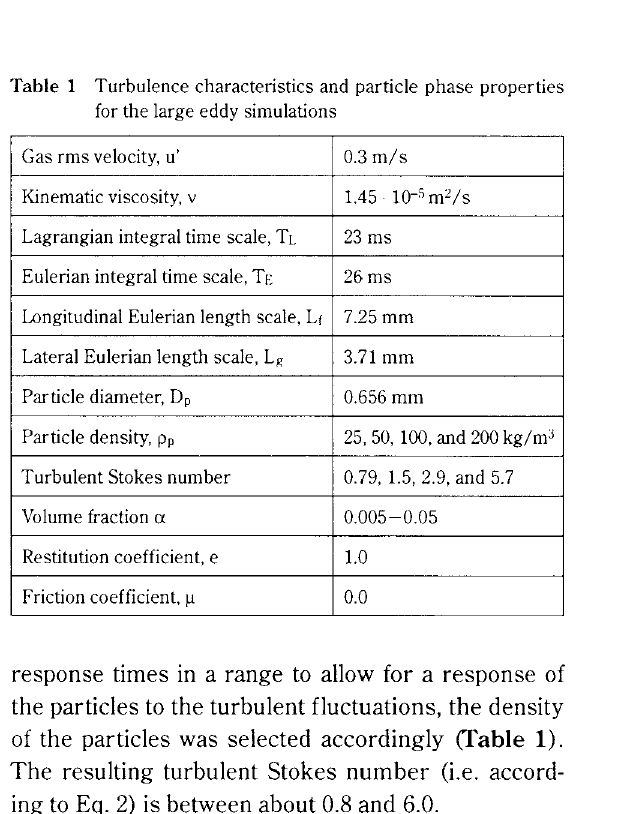
Table 1 Turbulence characteristics and particle phase properties for the large eddy